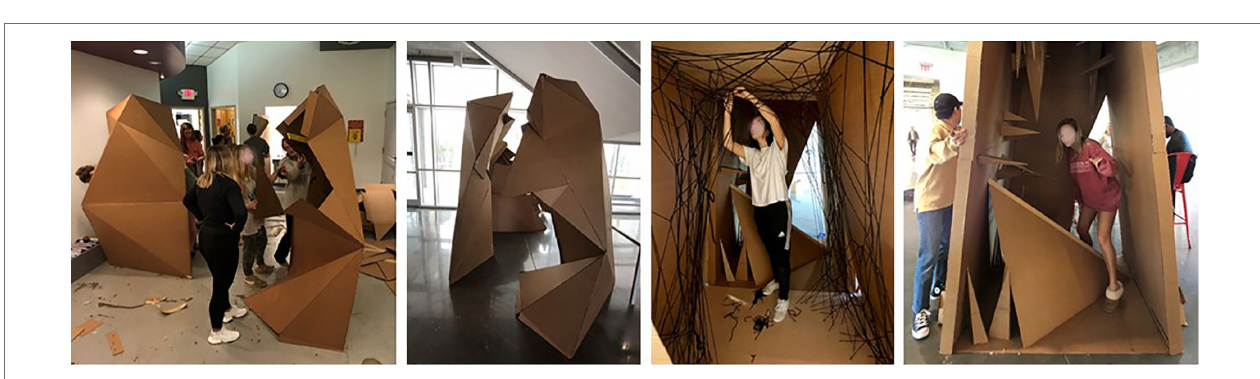
FIGURE 8 | Kinesthetic design process engaging the body: bodily experiment and ideation. Photo credit: Jain Kwon.